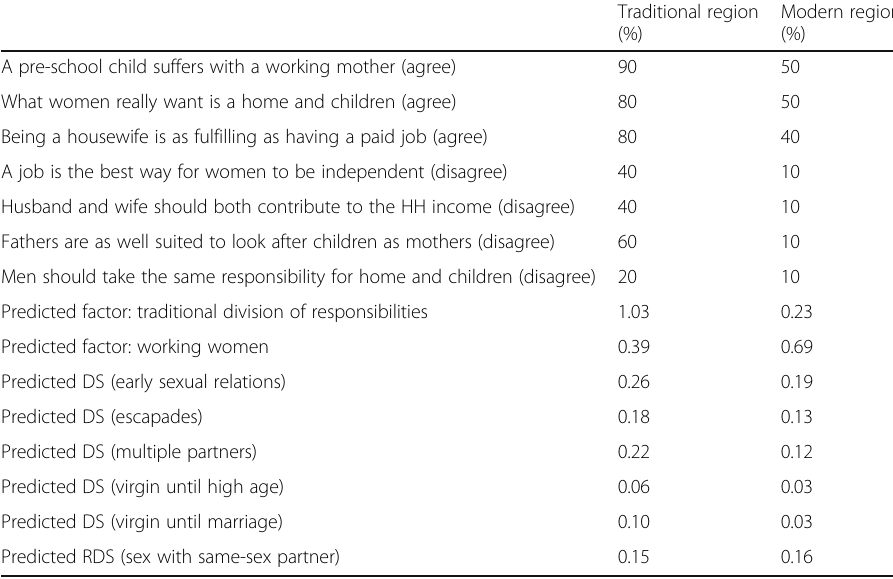
Table 5 Simulated context